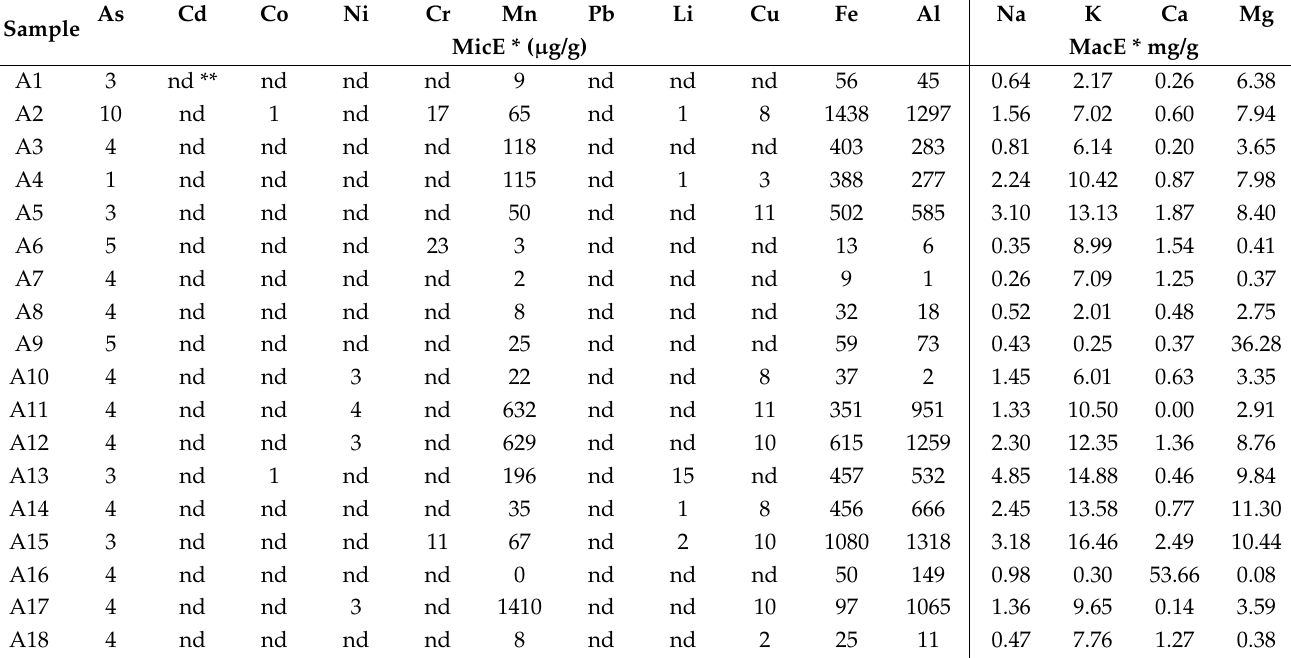
Table 5. Elemental impurities measured in 18 herbal weight loss